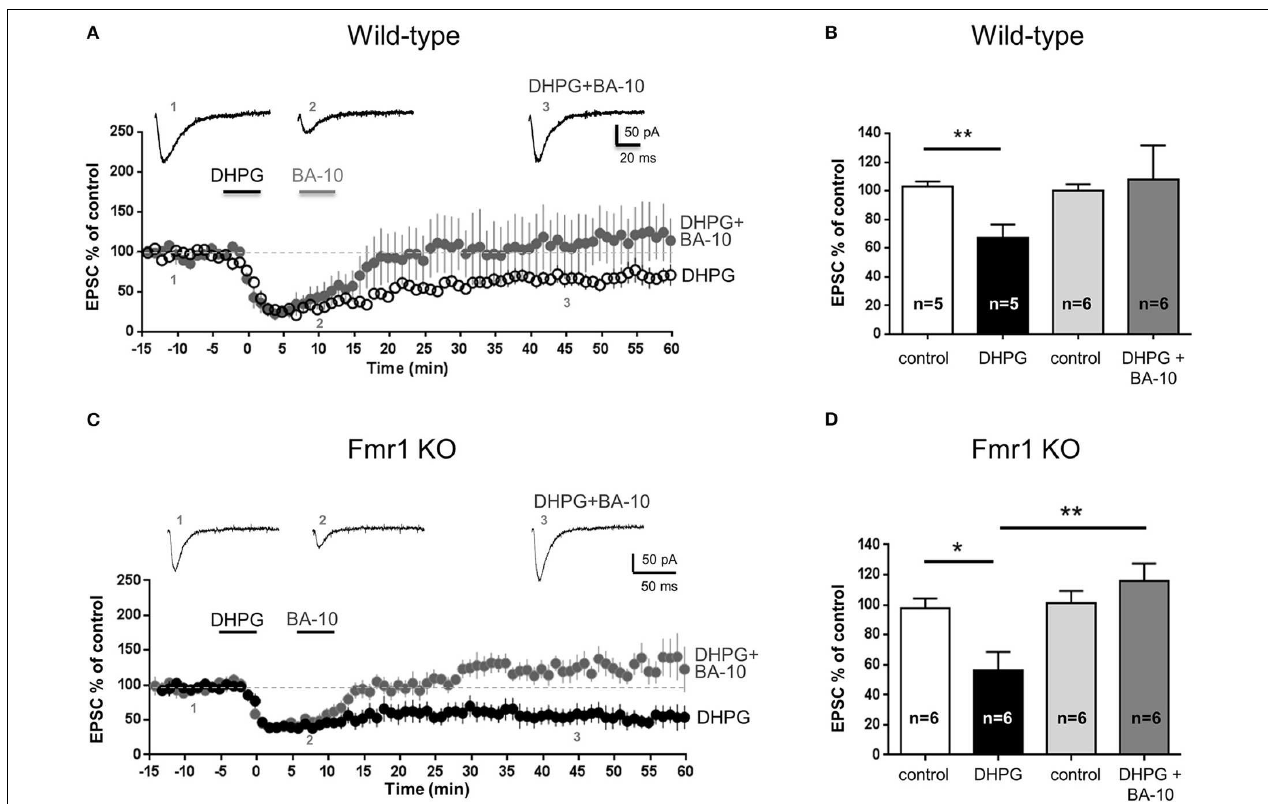
indicating that mGluR-LTD was completely reversed. This result shows that BA-10 behaved as an agonist of 5-HT 7 receptors. (C,D) In slices from Fmr1 KO mice (C57BL6J, PN 14-20), application of DHPG (100 µ M, 5min) induced a significant mGluR-LTD ( ∗ P = 0 .010, n = 6 ) that was completely reversed when BA-10 (10nM, 5min) was applied after DHPG ( P = 0 .29, n = 6 ). The amount of LTD induced by DHPG in the absence and in the presence of BA-10 was significantly different ( ∗∗ P = 0 . 0054 ). This result shows that BA-10 was able to reverse mGluR-LTD in a mouse model of Fragile X